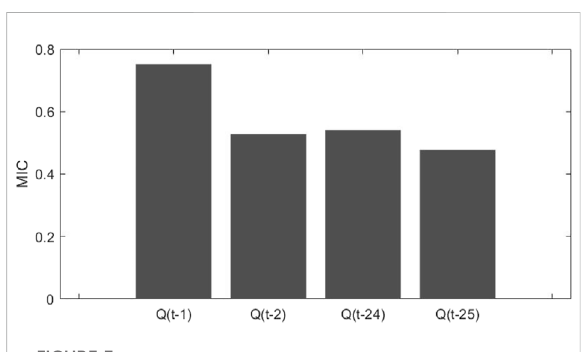
FIGURE 3 Impact of historical customer load on customer load.